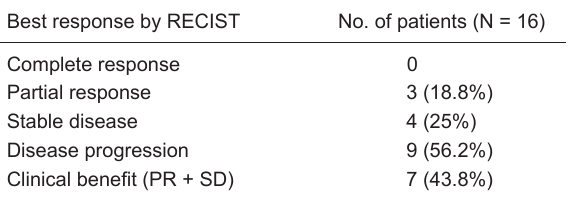
Table 2. Patient